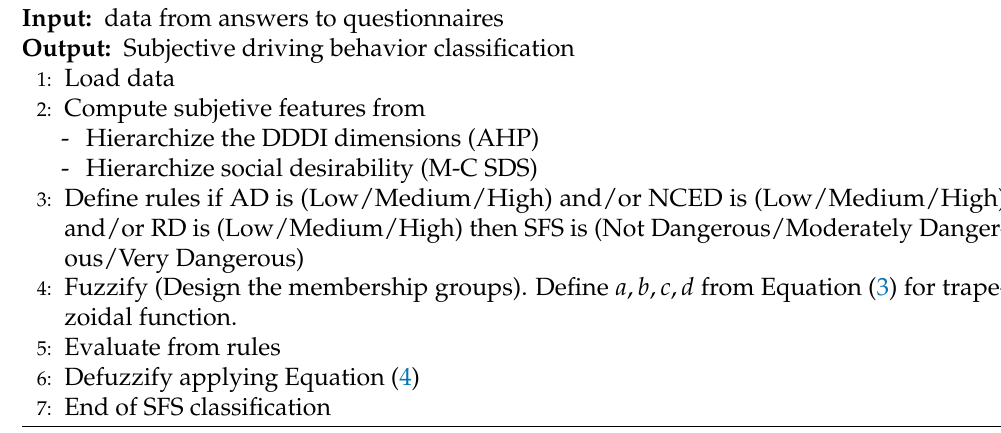
Algorithm 2 Driver classification